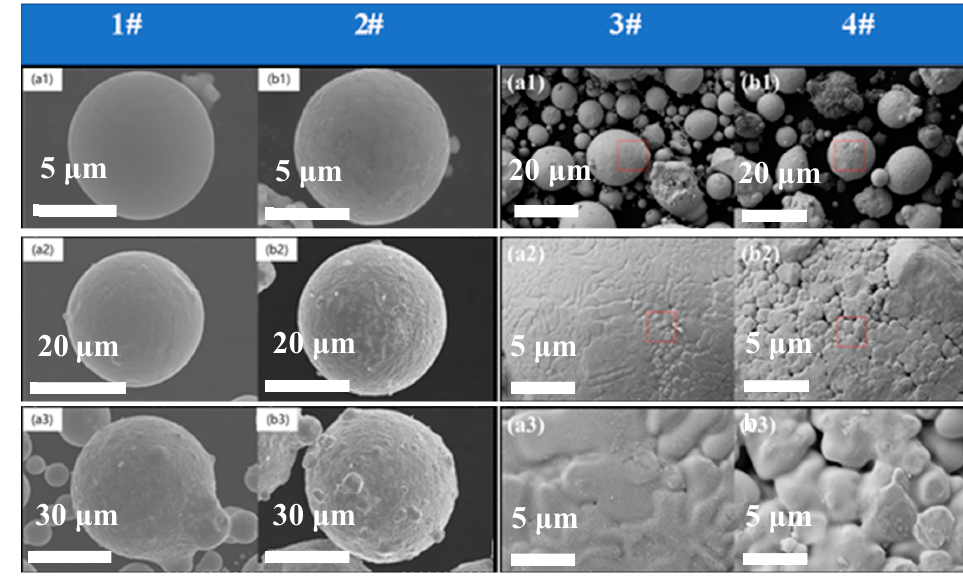
Figure 5. Surface morphology of four kinds of high entropy alloy powders in different particle size ranges. ( a1 , b1 ) The size range of powders less than 10 μ m of four powders. ( a2 , b2 ) The size range of powders from 10 μ m to 50 μ m of four powders. ( a3 , b3 ) The size range of powders is larger than 50 μ m.